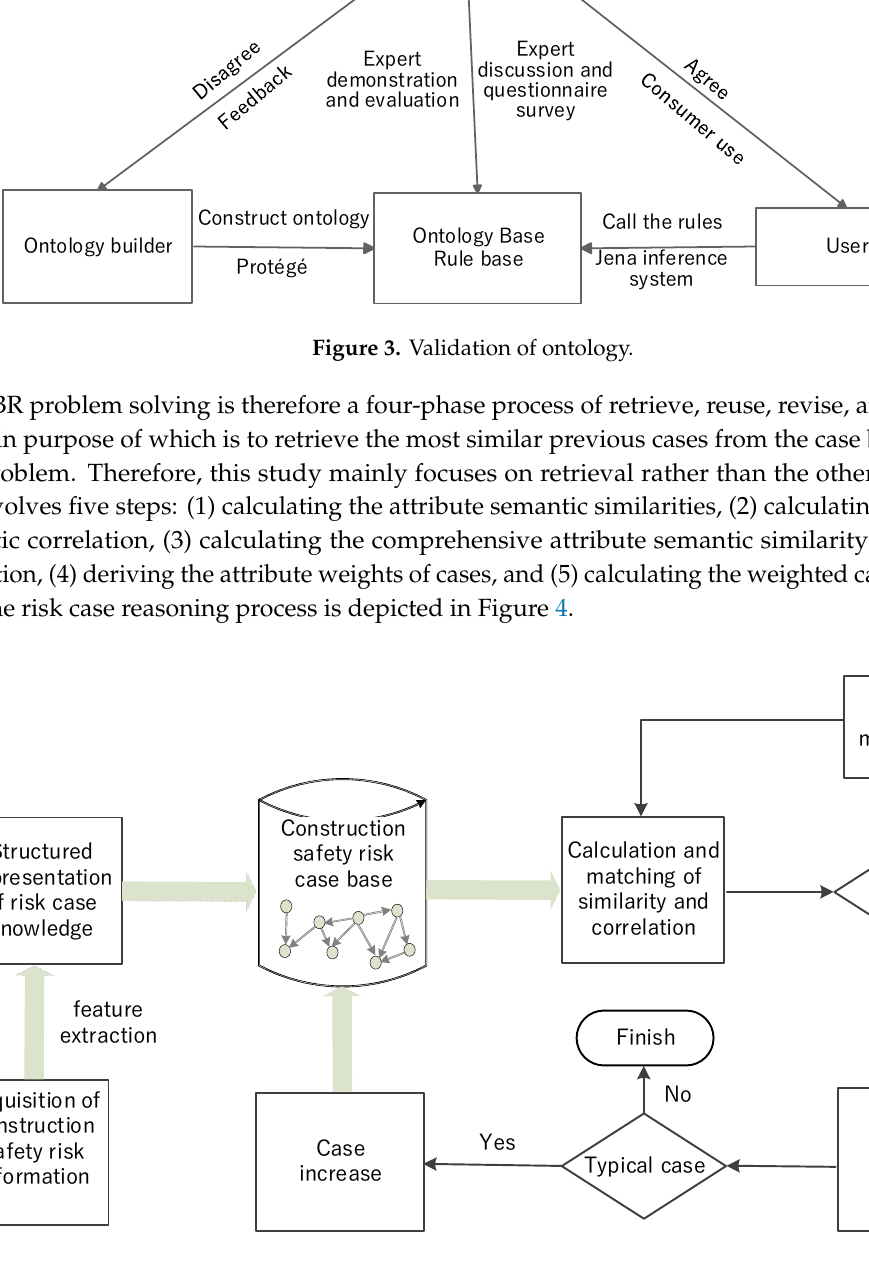
Figure 2. Seven-step construction process.